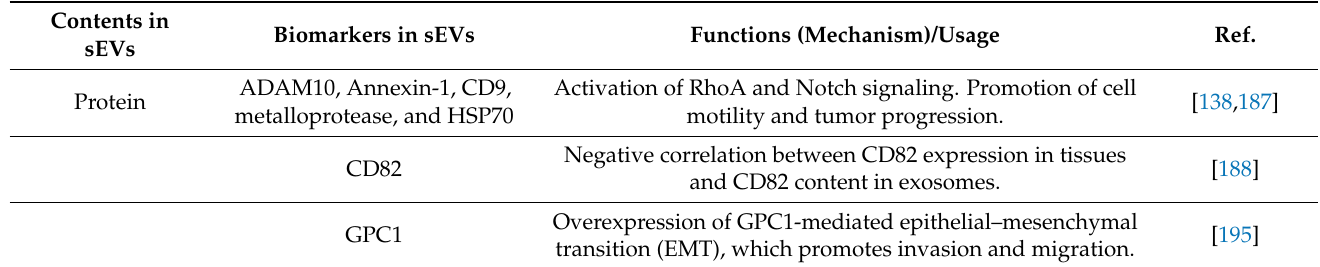
Table 2. sEVs’ proteins/RNAs of breast cancer possibly used for diagnostic/prognostic biomarkers for breast